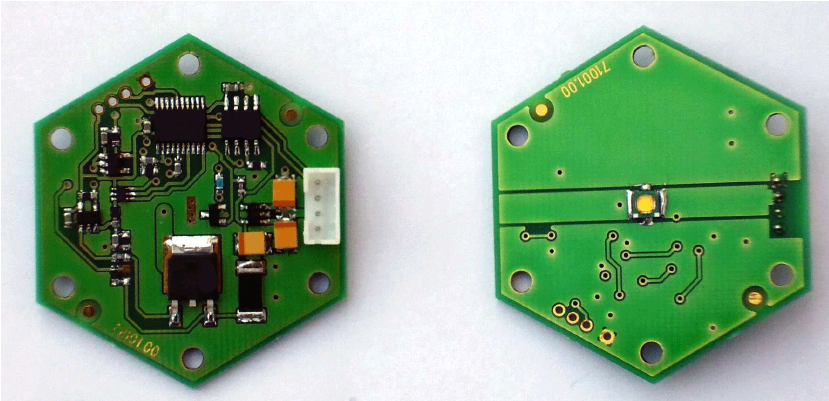
Figure 10. The prototype LED module on a hexagonal printed circuit board (PCB) with an outer diameter of 46